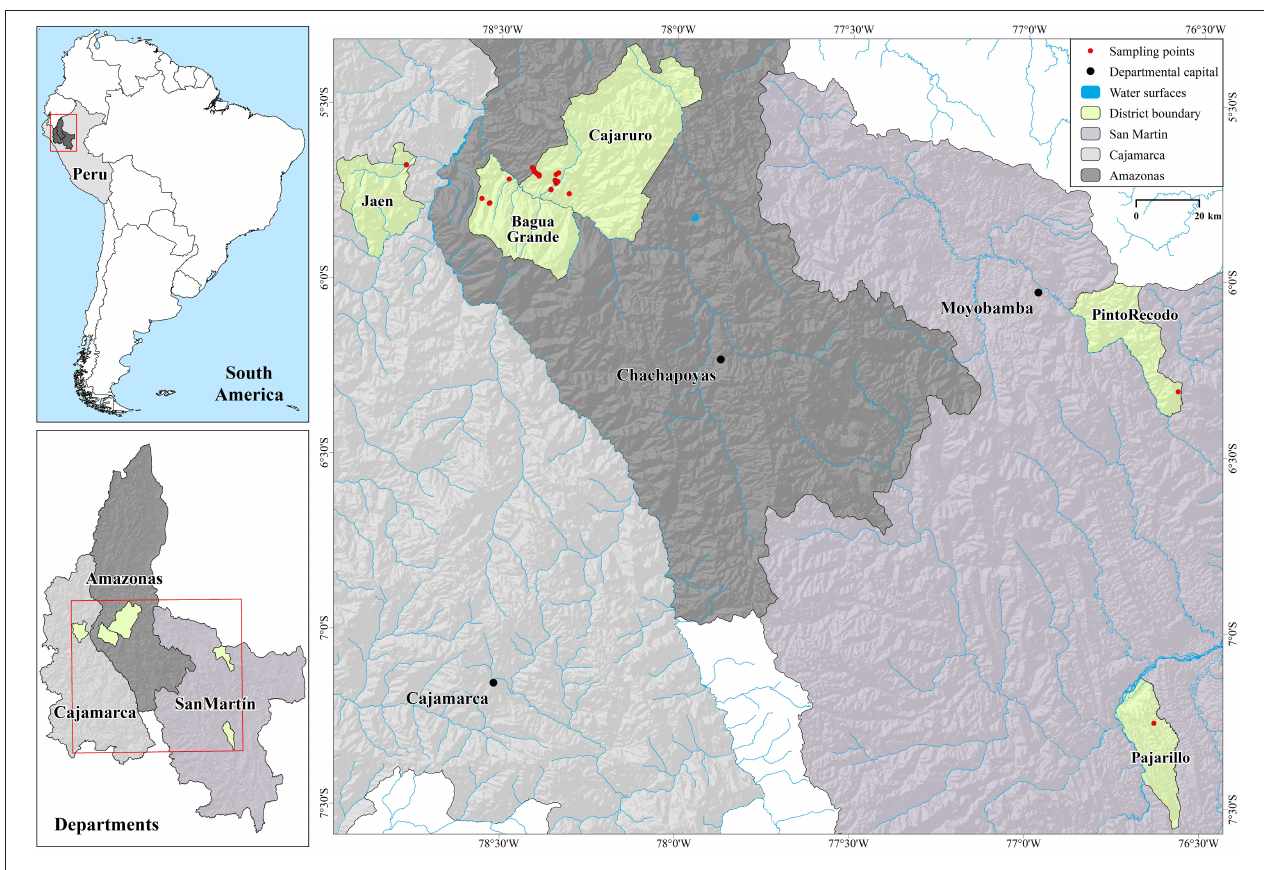
FIGURE 1 | Location of origin of fine-aroma cocoa